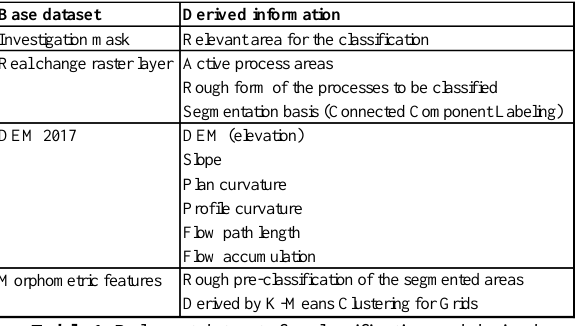
Table 1 . Relevant datasets for classification and derived